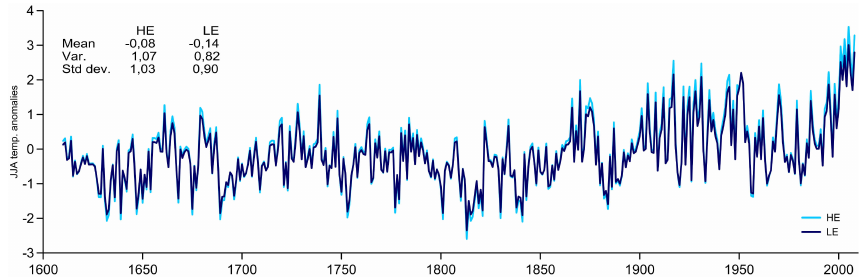
Fig. 4. The AdaPres JJA temperature reconstructions obtained after scaling against high-elevation (HE, light blue) and low-elevation (LE, dark blue) HISTALP datasets for the grid point 10 ◦ N, 46 ◦ E. In the table are reported mean, variance and standard deviation of the two time